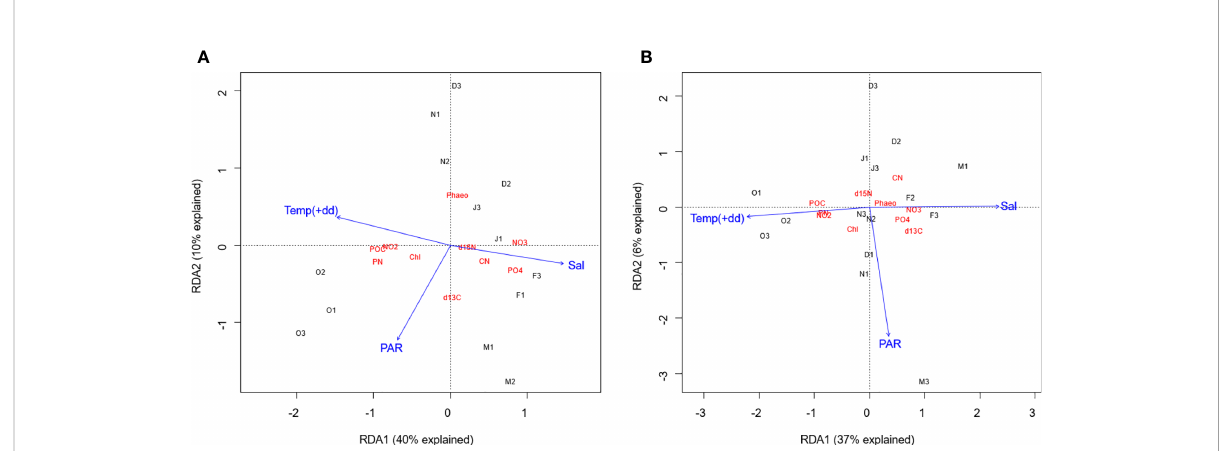
FIGURE 6 Redundancy analyses at (A) 5 m depth and (B) 30 m depth (RDA function in the vegan package in R) with three main physical drivers (blue). With PAR as proxy for light availability, Temperature in +-degree-days (days with mean air temperatures above 0°C, 4 weeks before the sampling) as proxy for potential freshwater runoff, and Salinity at 5 m depth as proxy for strati fi cation (Based on the assumption that salinity being the main driver of density variability). Explained variables (red) were the z-standardized (sd=1, mean=0) biogeochemical parameters. Samples (black) are indicated by the fi rst letter of their sampling month and station